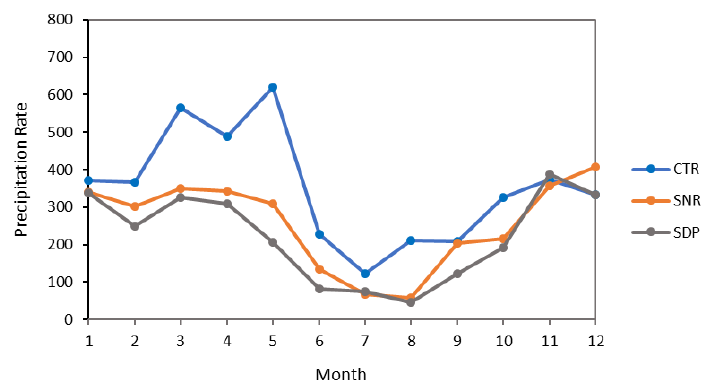
Figure 2. The monthly precipitation rates for the studied areas show a trend for higher precipitation at the CTR site than at the two other sites (SNR and SDP).